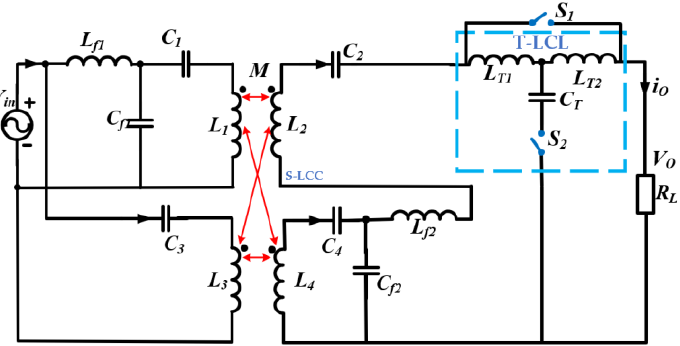
Figure 16. Hybrid and reconfigurable topology with misalignment tolerance [96].